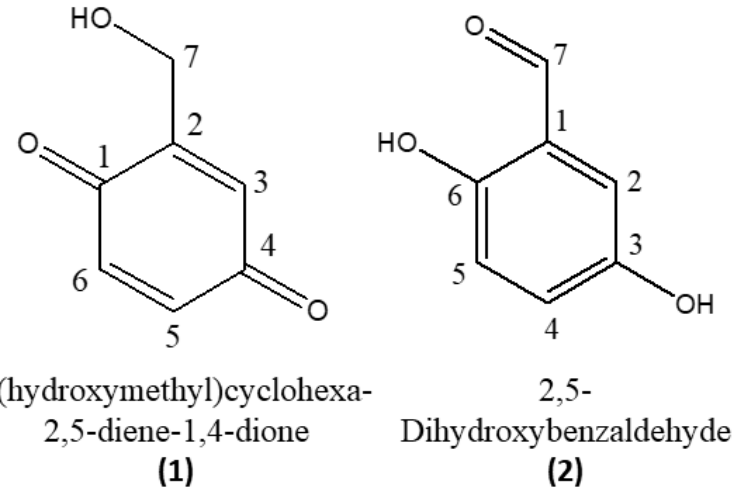
Figure 1. Chemical structure of compounds 1 and 2 , isolated from the culture filtrate of the grammicin-knockout mutant strain (TR74) of Xylaria grammica.